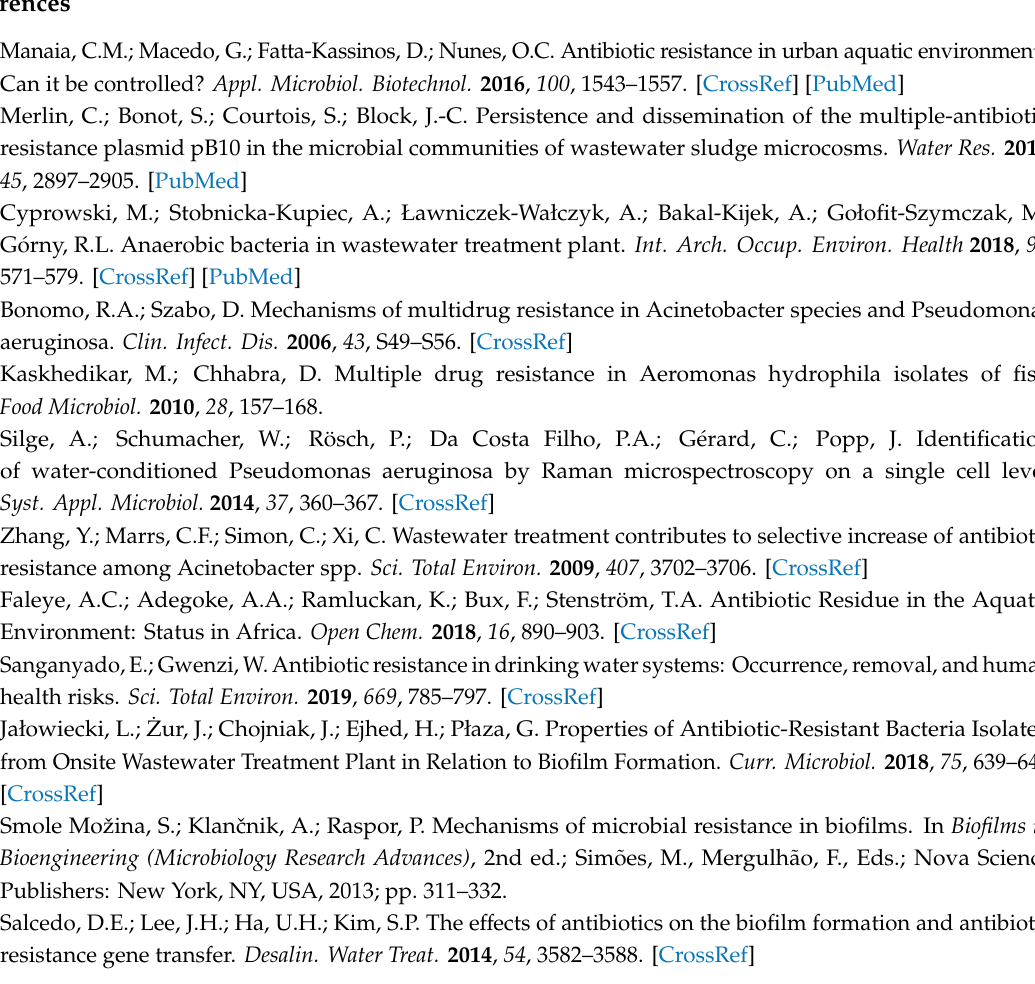
Figure S1: The growth curves of tetracycline-resistant isolates from the nitrification tank (NT) and the sedimentation tank (ST) of the wastewater treatment plant for the preparation of the hydrophobicity test. The growth curves measured every 30 min 24 h at 600 nm and 30 ◦ C, Table S1: Concentration (ng / µ L) and purity (A260 / A280) of DNA samples from the wastewater of the nitrification and sedimentation tanks of the wastewater treatment plant for the quantification of antibiotic resistance genes, Table S2: Primers sequences and PCR and qPCR conditions used for detection and quantification of tet genes in wastewater samples and selected bacterial isolates, Table S3: The parameters of the growth curves of tetracycline-resistant isolates from the nitrification tank (NT) and the sedimentation tank (ST) of the wastewater treatment plant for the preparation of the hydrophobicity test. The growth curves measured every 30 min 24 h at 600 nm and 30 ◦ C, Table S4: E ffi ciency of qPCR assays retrieved from standard